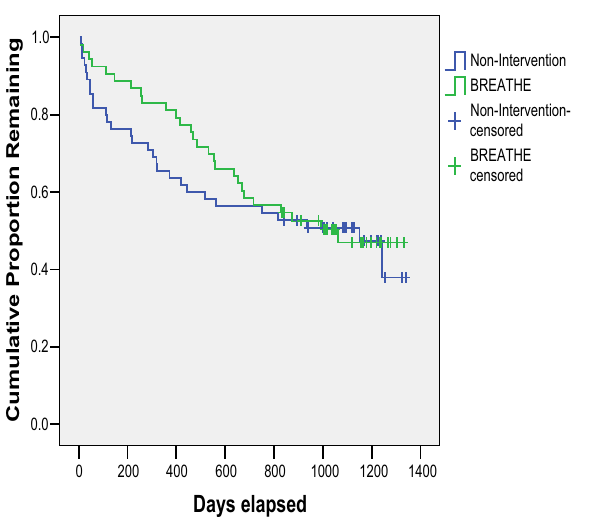
Figure 2. Time to event from participant intervention initiation to first ED visit or hospitalization, by group status.